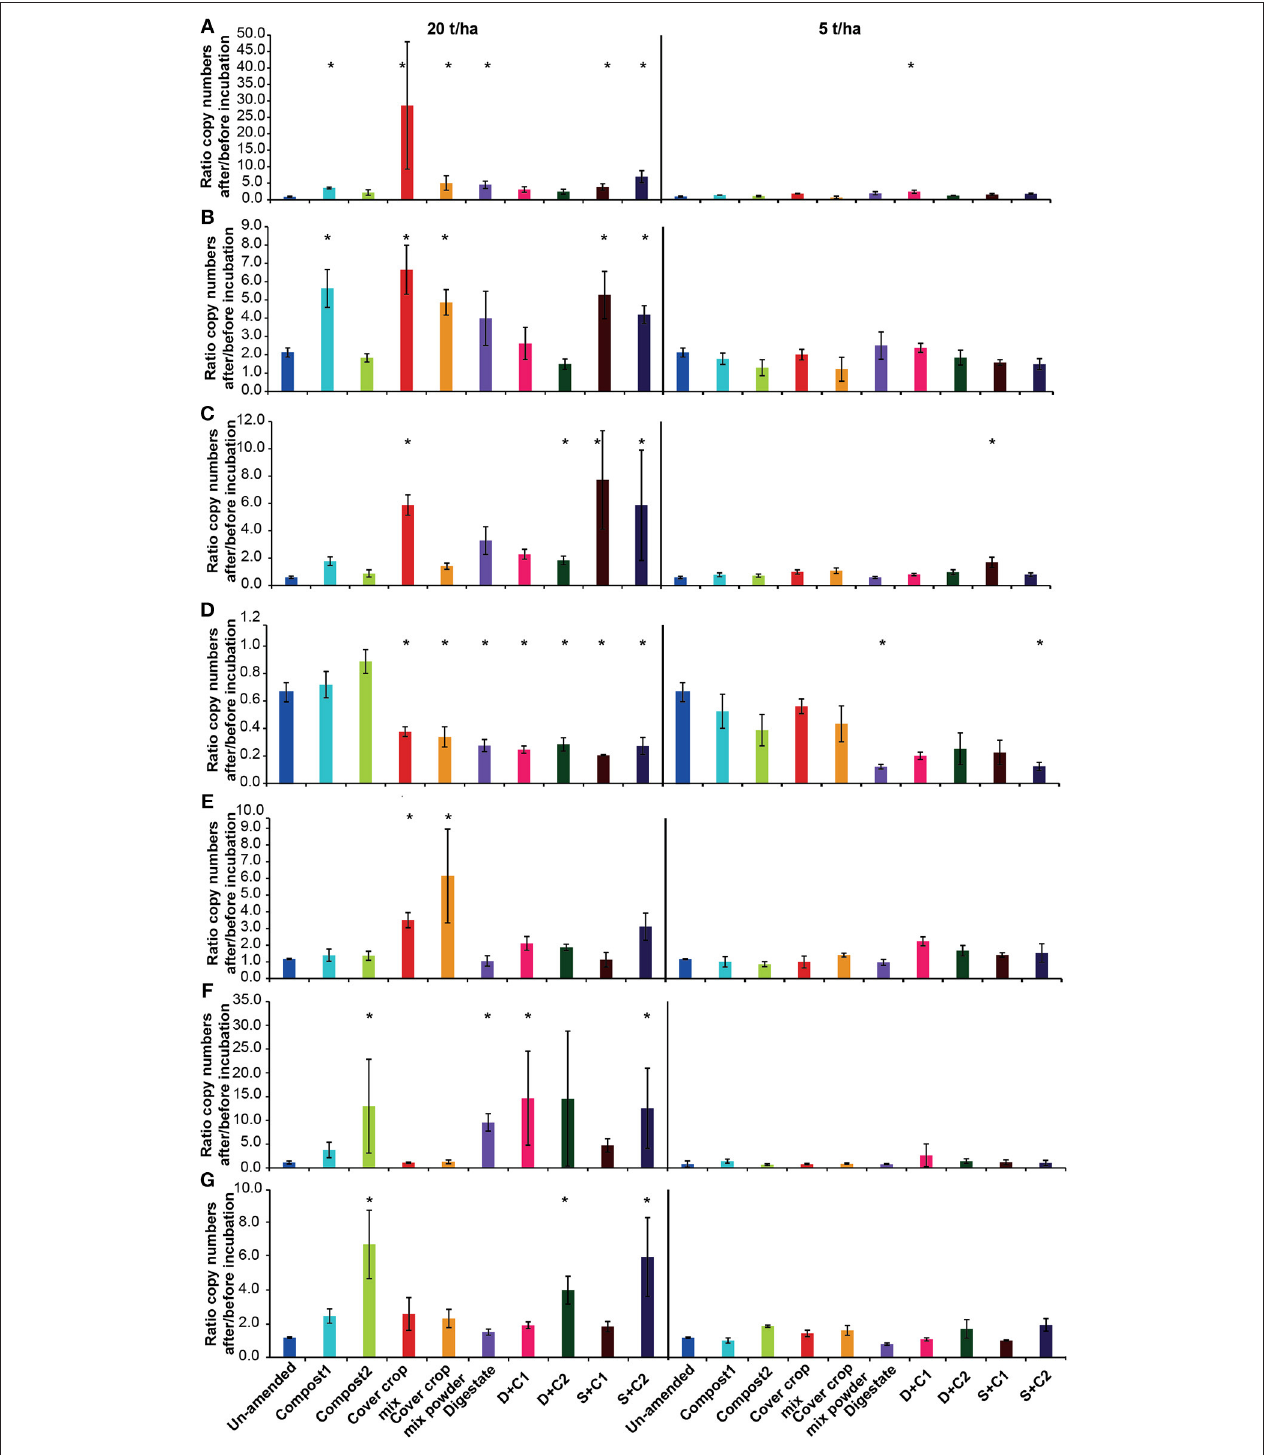
FIGURE 7 | Ratio of the copy numbers of the functional marker genes (A) nosZ clade I, (B) nosZ clade II, (C) bacterial amoA , (D) archaeal amoA , (E) nifH , (F) mcrA, and (G) pmoA after and before an incubation of un-amended clay soil and during amendments with compost1, compost2, CC residues mixtures, digestate, digestate + compost1, digestate + compost2, sewage sludge + compost1, and sewage sludge + compost2 (mean ± SD; n = 3) for 28 d. Asterisk (*) indicate significant differences in the ratio of the individual genes in the soils with organic amendments and the un-amended soil within the four separate superordinate treatments (ANOVA: P <